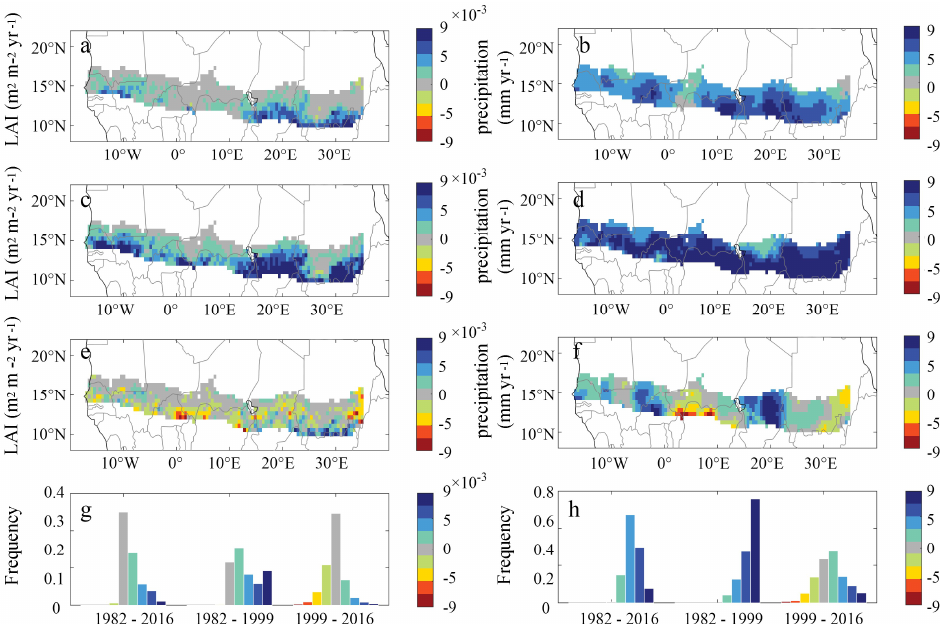
Figure 3. Grid trends (per year) of LAI (m 2 m -2 yr −1 × 10 −3 ) and precipitation (mm yr -1 ) during the two periods divided by the turning point in 1999. ( a–b ) LAI and precipitation annual trend during the whole study period 1982–2016. ( c–d ) Corresponding trend for the period of 1982–1999. ( e–f ) Annual trend between 1999 and 2016. ( g–h ) The frequency distributions of corresponding trends of the LAI and precipitation.